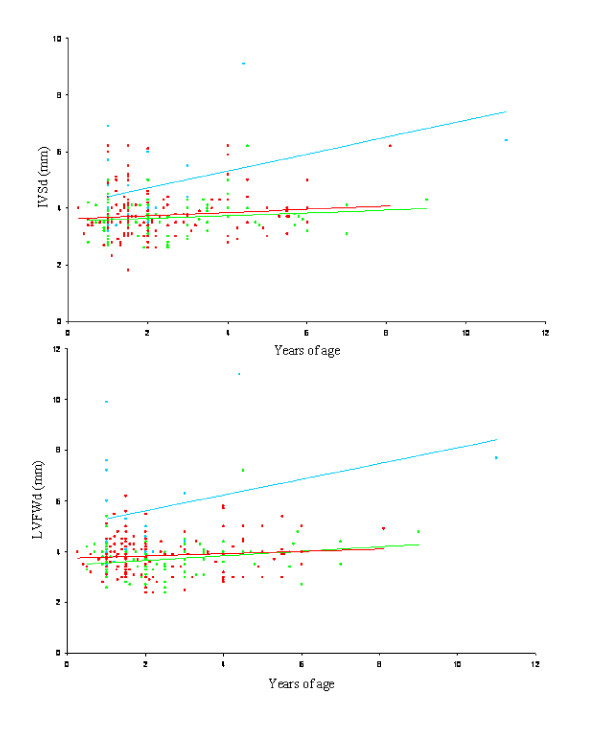
The correlation with age and diastolic IVS and LVFW measurements as a function of c.91C MYBPC3 alleles. Top: Plot of diastolic IVS correlation with age as a function numbers of c.91C MYBPC3 alleles. There was tendency to an increasing effect of p.A31P cMyBP-C homozygosity with age, though the tendency was not significant, ρ = 0.41, P = 0.09. There was only a low effect of being p.A31P cMyBP-C heterozygous, ρ = 0.09, P = 0.4. Bottom: Plot of diastolic LVFW correlation with age as a function of numbers of MYBPC3 c.91C alleles. The tendency was more weak than seen above, ρ = 0.2, P = 0.50. Red indicates the cMyBP-C wild type coordinates and the corresponding line of tendency. Green indicates p.A31P cMyBP-C heterozygous coordinates and the corresponding line of tendency. Blue indicates p.A31P cMyBP-C homozygous where and the corresponding line of tendency. Figure abbreviations: IVSd: diastolic interventricular septum, LVFWd: diastolic left ventricle free wall.